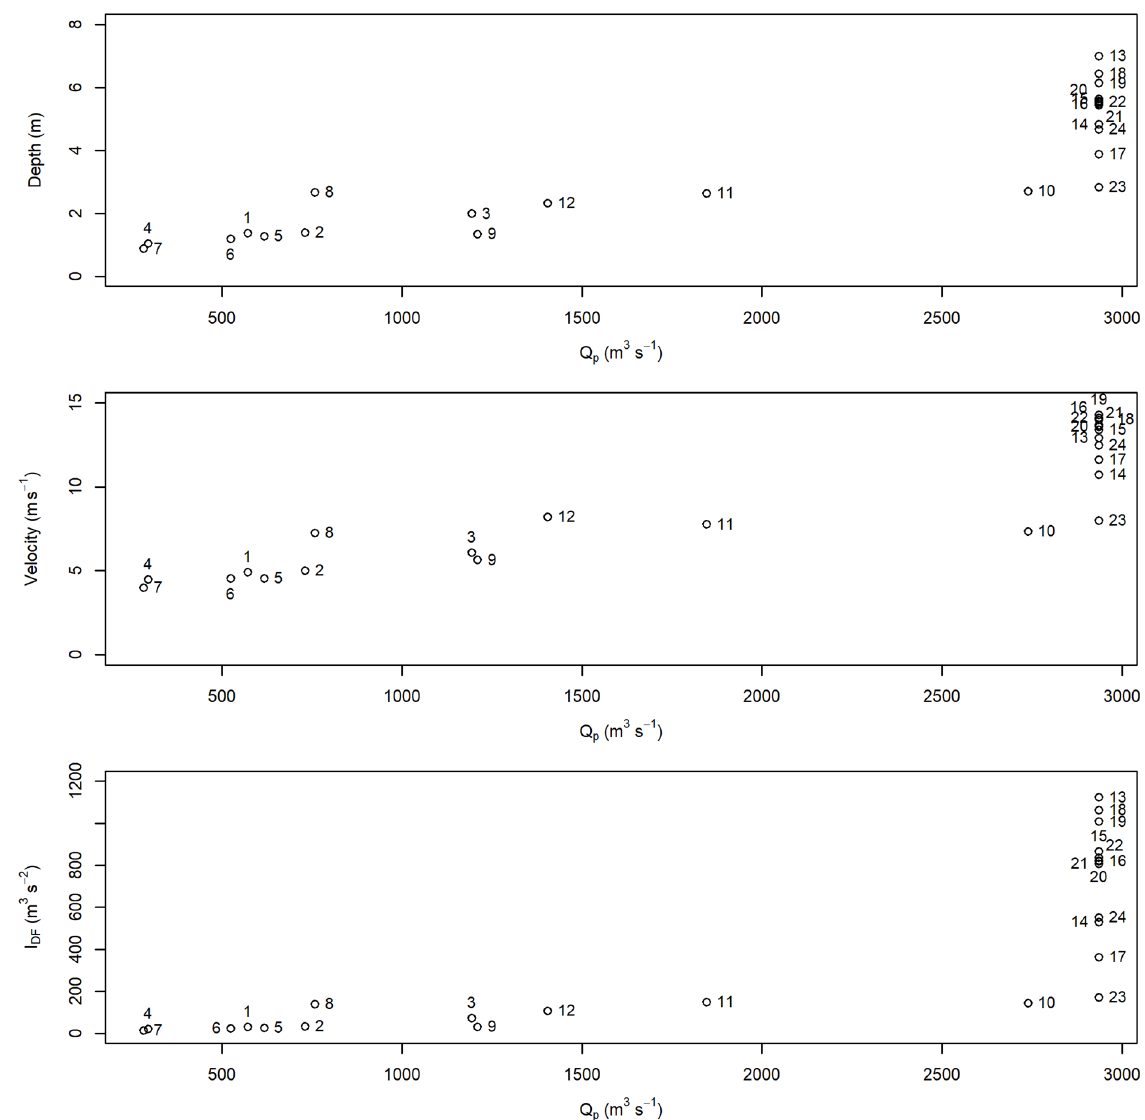
Figure A6. Relationships between peak discharge and flow depth, velocity, and I DF for the numerical flume at x = 1000m. The numbers correspond to the hydrograph IDs summarized in Table